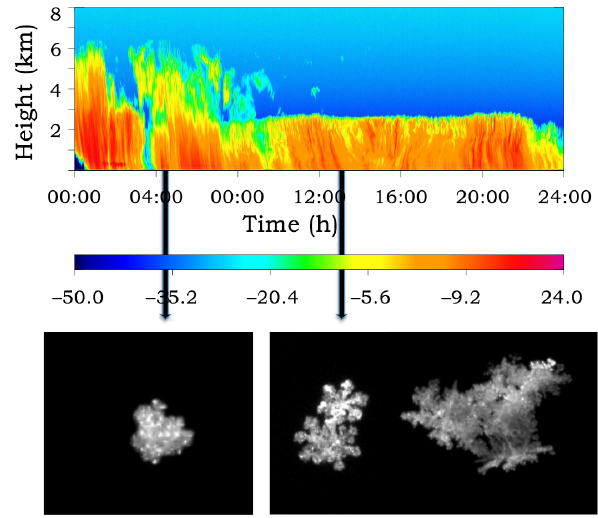
Figure 4. The top scene shows KAZR reflectivities (dBZ) for a 23 April snow event at the NSA Barrow site. MASC images of snowflakes suggest a graupel-like structure around 04:00UTC which transitioned to more pristine structures and aggregates by